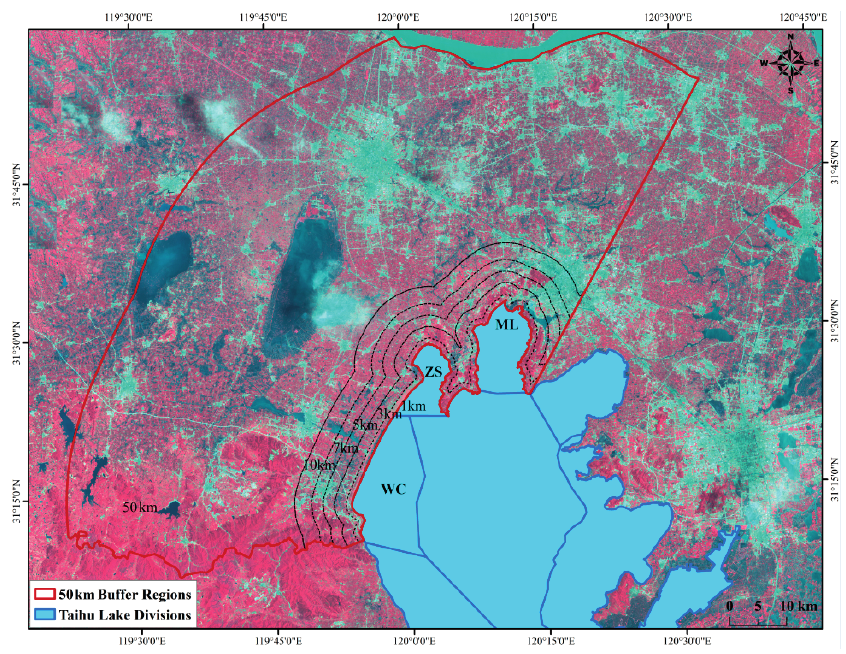
Figure 1. The location of study site and three lake